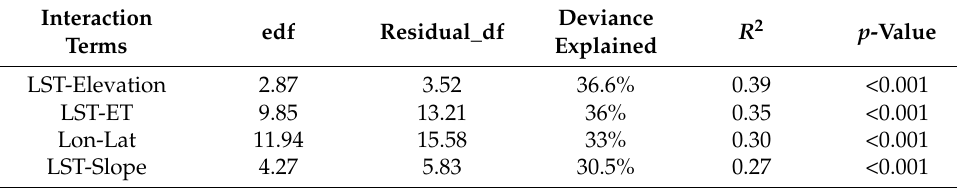
Table 8. Interactions of significant variables on AGB in GAMs.